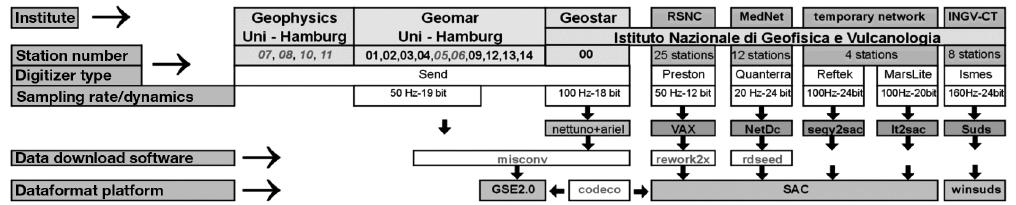
Fig. 2. Organisation of seismic data acquired and used in the framework of the TYDE experiment. GEOMAR, Uni-Hamburg, and GEOSTAR are in charge of the OBS/OBH instruments used during the experiment. Istituto Nazionale di Geofisica e Vulcanologia is responsible for the on land networks: for this study we did not use the MedNet and temporary networks data set. An OBH was mounted on all the off-shore stations; the number of the station is typed in italic style when an OBS sensor was mounted, too. In the figure, the characteristics of seis- mic sensors and the procedures to unify the data format are